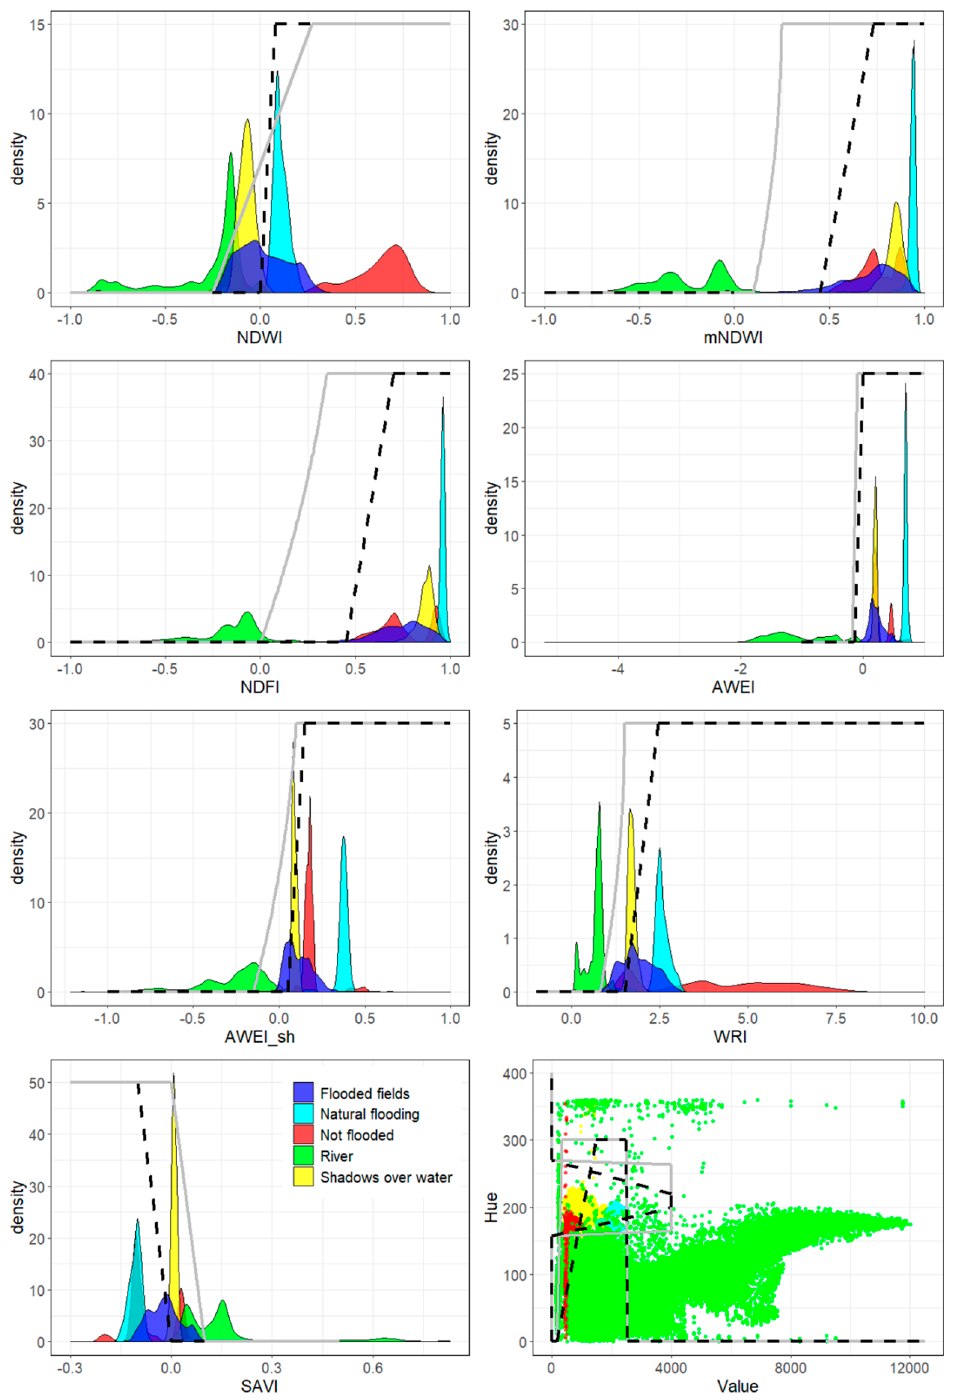
Figure 5. Black dotted lines identify soft constraints defined by expert A with a risky attitude (i.e., optimistic) in mapping standing water, regarded as a negative phenomenon, by taking into account the ability of soft constraints to separate the distributions of standing water (comprising the three classes: “natural flooding”, “flooded fields” and “rivers”) with respect to the “not flooded” class. The grey continuous lines identify the soft constraints defined by expert B with a precautionary attitude (i.e., pessimistic) by taking into account the ability of soft constraints to separate the distributions of standing water (comprising the four classes: “natural flooding”, “flooded fields”, “rivers” and “shadows over water”) with respect to the “not flooded” class. Notice that the bottom–right diagram illustrates the two pairs of soft constraints on the hue and value of the triad HSV defined by experts A and B.